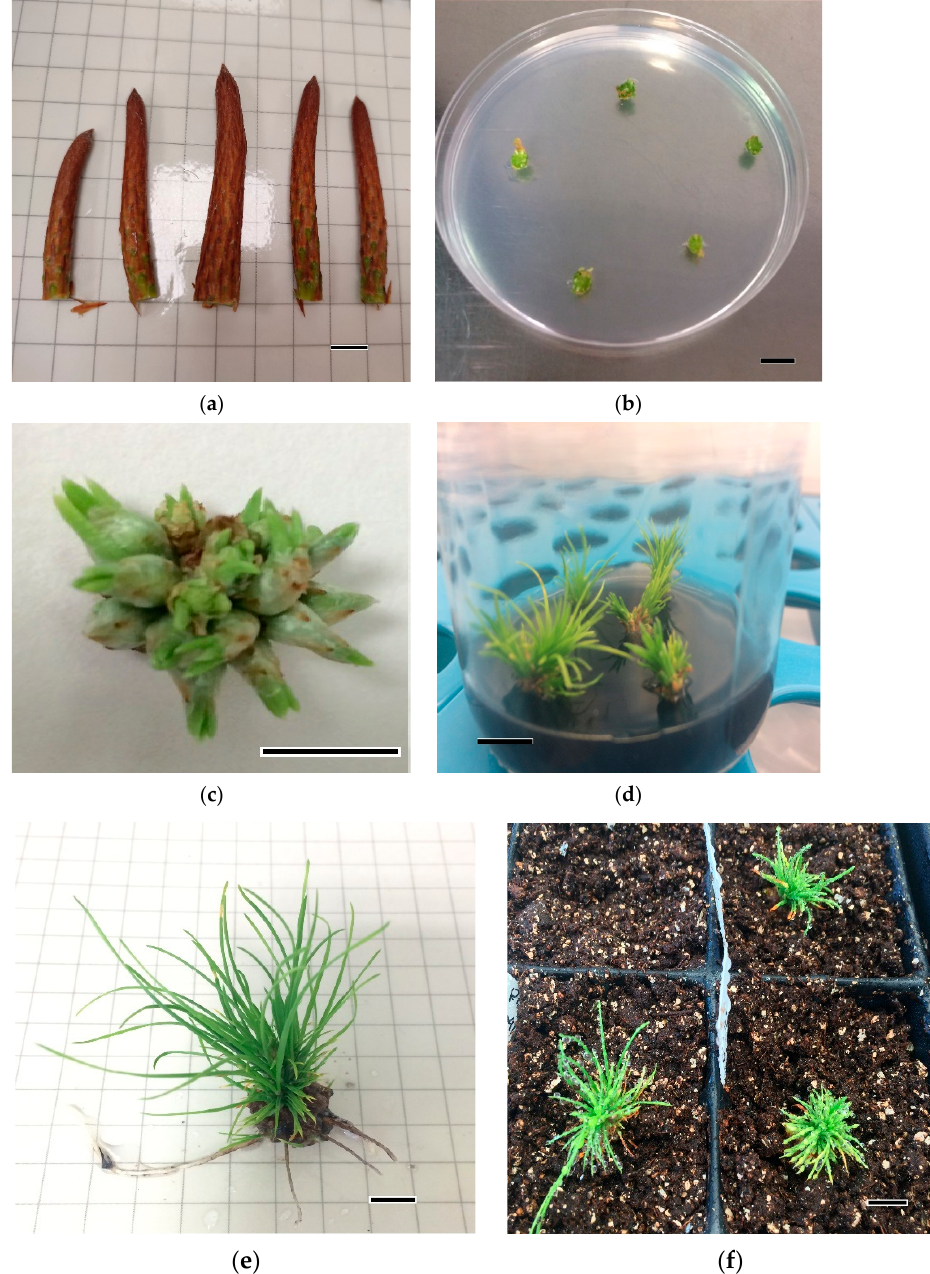
Figure 1. Organogenic process in apical shoot buds from Pinus radiata D. Don adult trees: ( a ) apical shoot buds, bar = 1 cm; ( b ) shoot bud slices in culture, bar = 1 cm; ( c ) shoot bud slice after induction with 22 μ M 6-benzyladenine (BA), bar = 1 cm; ( d ) shoots in elongation medium, bar = 1 cm; ( e ) rooted shoots, bar = 1 cm; ( f ) acclimatized shoots, bar = 3 cm.